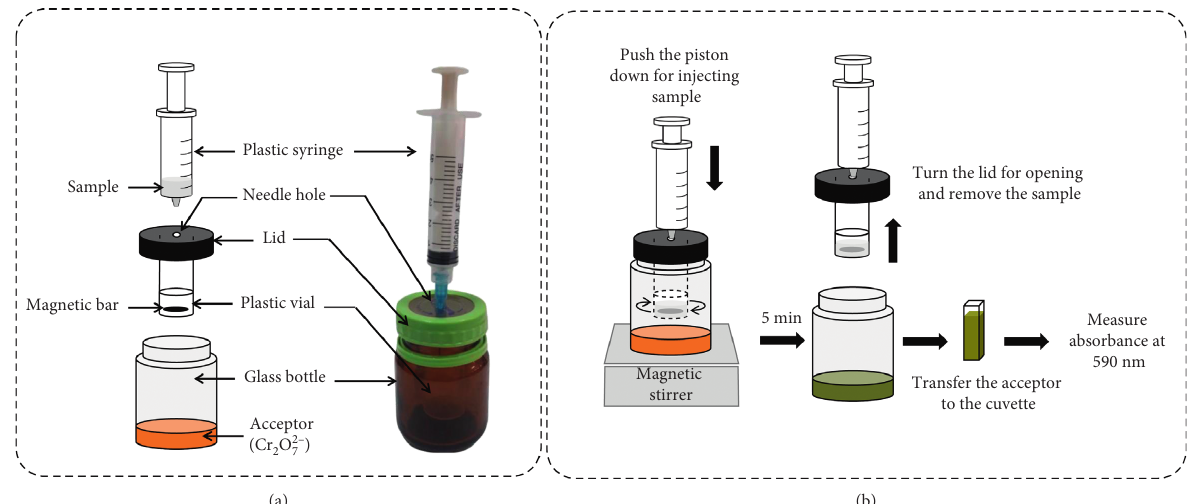
Figure 1: Construction (a) and brief operational procedure (b) of the MBL-VP unit for colorimetric determination of ethanol in